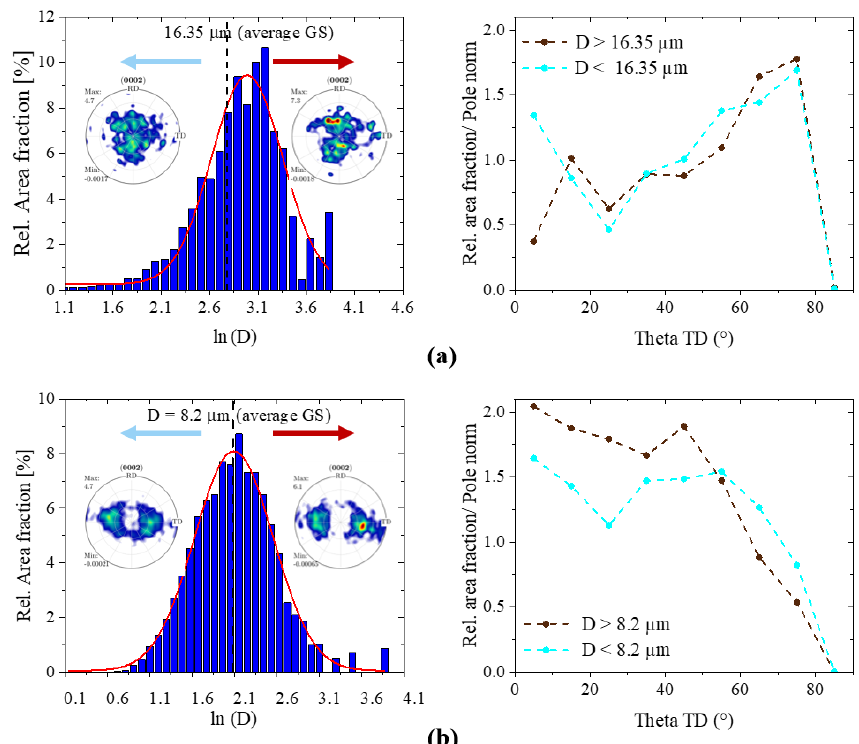
Figure 10. Grain size distributions from EBSD measurements of Mg-1%Er annealed at 400 ◦ C for 4 min ( a ) and Mg-1%Er- 1%Zn annealed at 350 ◦ C for 10 min ( b ) along with the orientation distribution of the c-axis with respect to TD for small and large recrystallized grains. The threshold used in each case was the average grain size obtained from EBSD.